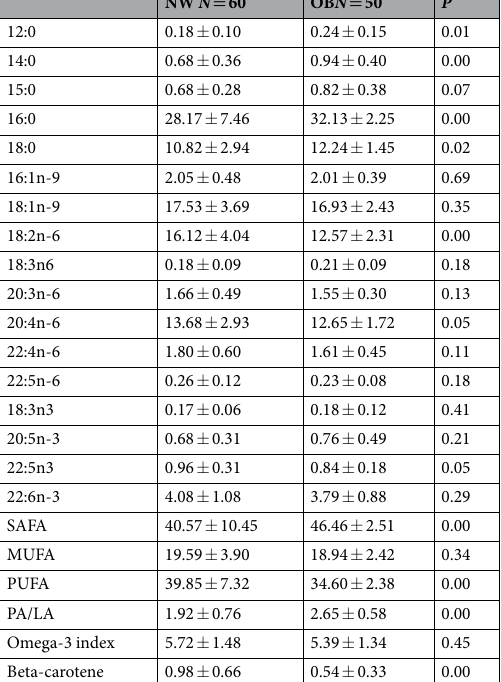
Table 3. Erythrocyte fatty acid profile and plasma beta-carotene level of participants with normal weight (NW) or with obesity (OB). The erythrocyte fatty acids are expressed as mol% of total fatty acids, whereas the beta- carotene is expressed as nmoles/ml plasma. Mean ± SD; P was assessed using an unpaired, two-tailed Student’s